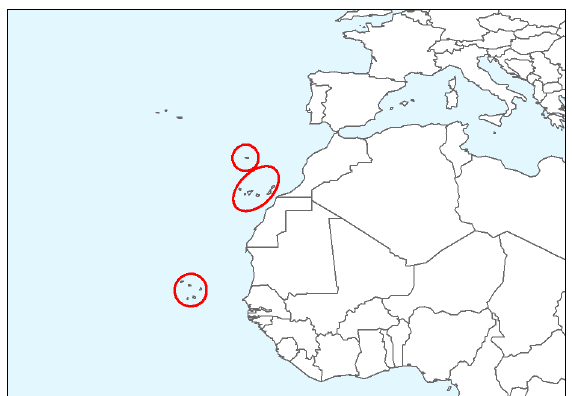
Fig. 4. Native range on an archipelago: Dracaena